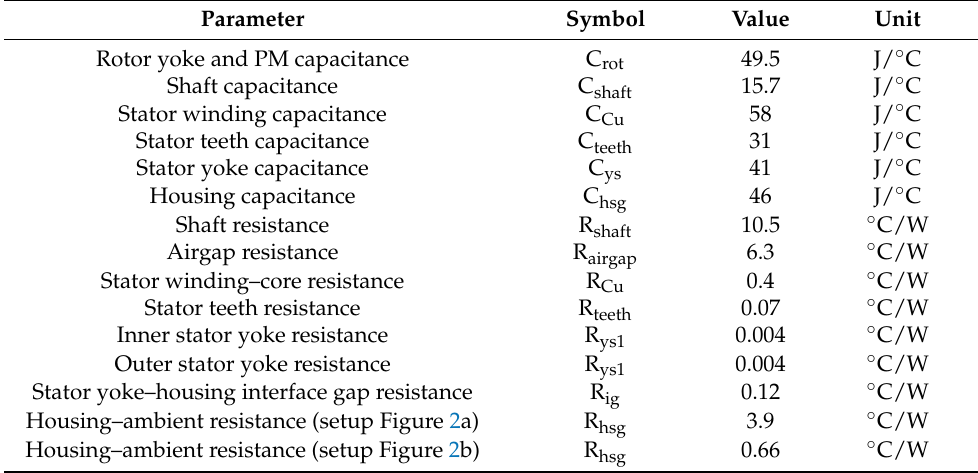
Table 2. Computed and calibrated thermal